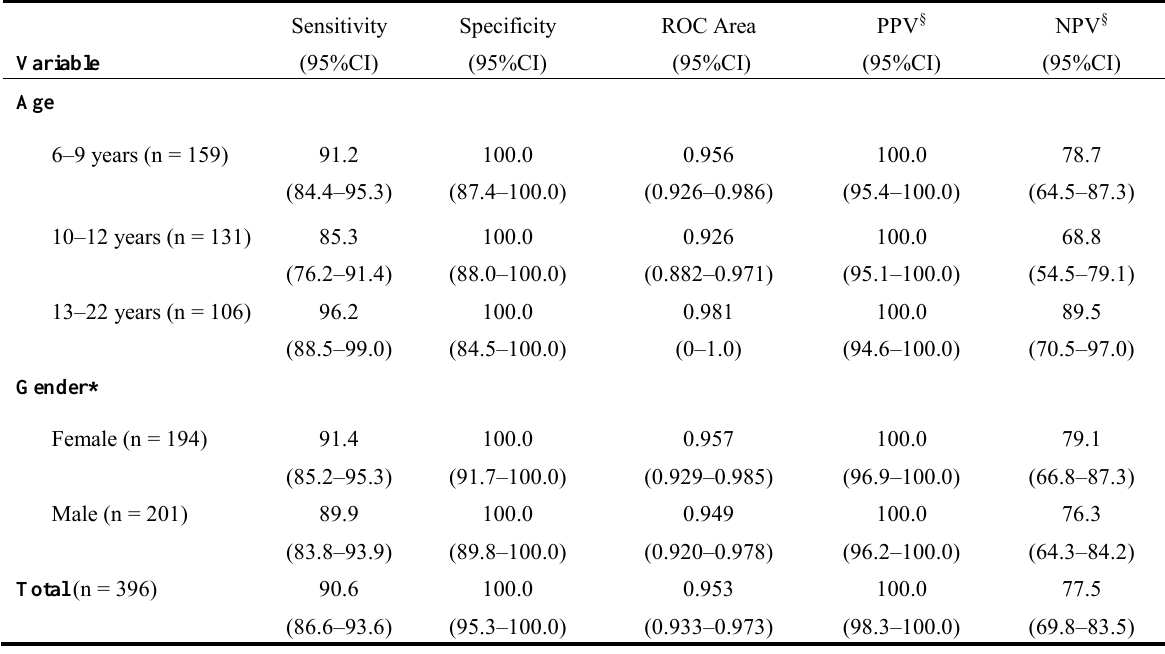
Table 2. Sensitivity, specificity, accuracy, positive and negative predictive values achieved using the simplified TF index to determine the presence or absence of any degree of dental fluorosis when compared to the gold standard (full mouth TF index), rural communities, Brazil.